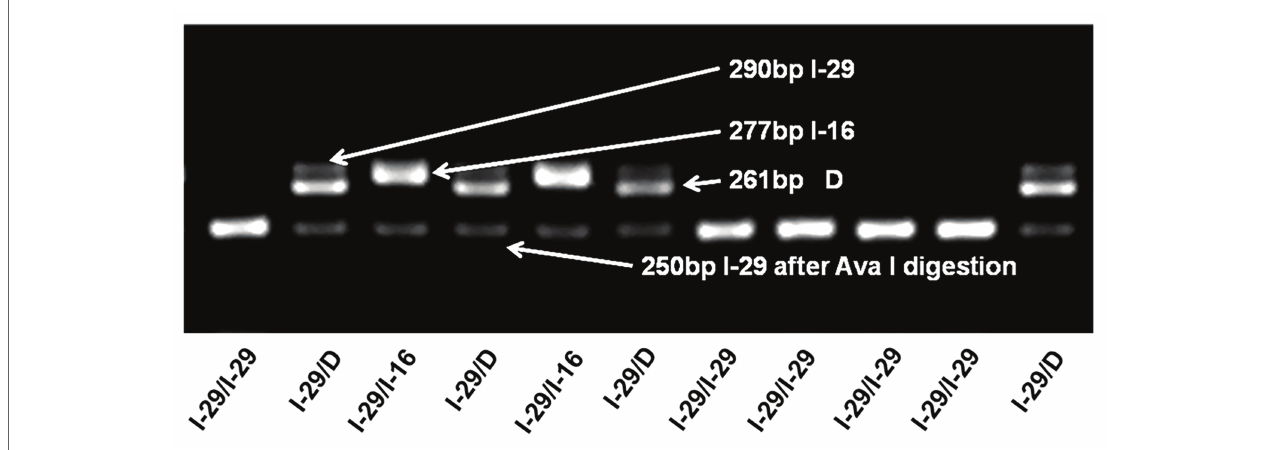
FIGURE 1 | Genotyping of the tri-allelic polymorphism in NQO2. A typical gel electrophoresis plot of the I-29/I-16/D polymorphism is shown. Samples are assayed by PCR and electrophoresis. I-29 (290 bp) can be digested by Ava I into 250 and 40 bp fragments, but I-16 (277 bp) and D allele (261 bp) cannot. Correspondingly, I-29/I-29 can be completely digested, and no band is observed at 290 bp. In contrast, I-29/I-16 has two bands, one is 250 bp, and the other is 277 bp. For I-29 heterozygotes, even with enough restriction enzymes, I-29 alleles may not be completely digested, leaving a shadow band at 290 bp. This may be because Ava I cannot effectively cleave the dimeric I-29/I-16 or I-29/D complex.